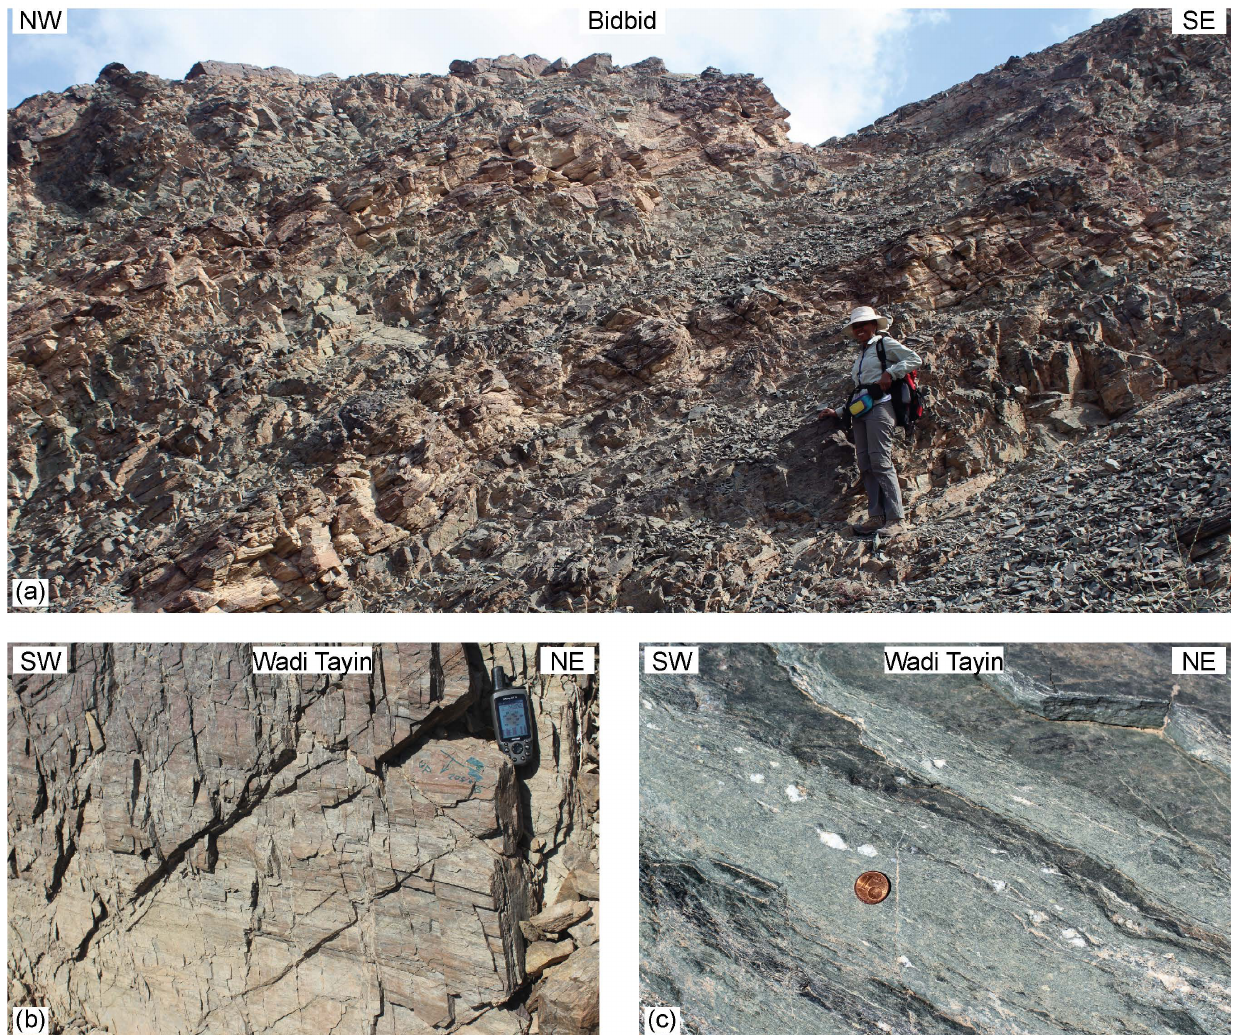
Figure 3. ( a ) The sampling site of MS 1 and 2 near Bidbid (N 23 ◦ 25 (cid:48) 24.6”, E 58 ◦ 8 (cid:48) 32.0”). Interlayering of quartzite (light rocks) and amphibolite (dark rocks); ( b ) mylonitic greenschist with asymmetric σ -clasts, indicating top-to-the-southwest sense of shear, approximately 500 m above the sampling site of MS 8, Wadi Tayin; ( c ) quartzite of the sampling site of MS 8 (N 23 ◦ 3 (cid:48) 53.9”, E 58 ◦ 35 (cid:48) 49.9”, Wadi Tayin) characterized by steep mylonitic foliation (028/68) and strong stretching lineation (L 028/61), indicating a high amount of simple